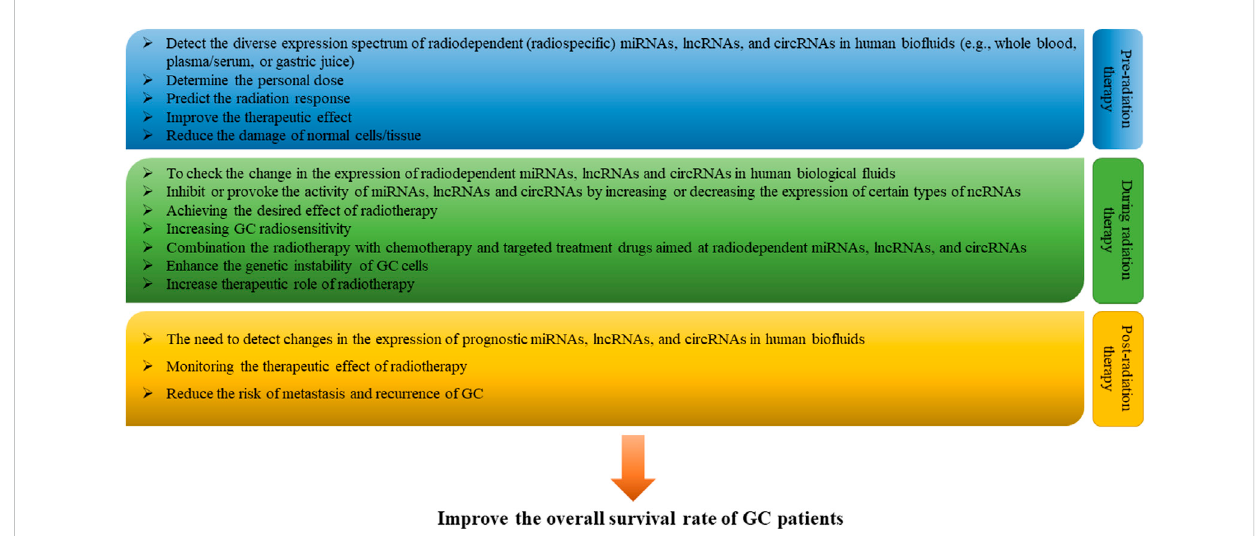
FIGURE 4 Clinical perspective of microRNAs (miRNAs), long non-coding RNAs (lncRNAs) and circular RNAs (circRNAs) in gastric cancer (GC) radiotherapy. In the future, in clinical practice with the use of radiotherapy, it is possible to assess and monitor the range of changes in the expression of radiodependent miRNAs,lncRNAs,andcircRNAsinhumanbio fl uids(e.g.,wholeblood,plasma/serum,orgastricjuice)pre-radiationtherapy,duringradiationtherapy,and post-radiation therapy periods in order to enhance the therapeutic effect of radiotherapy and improve the overall survival of GC